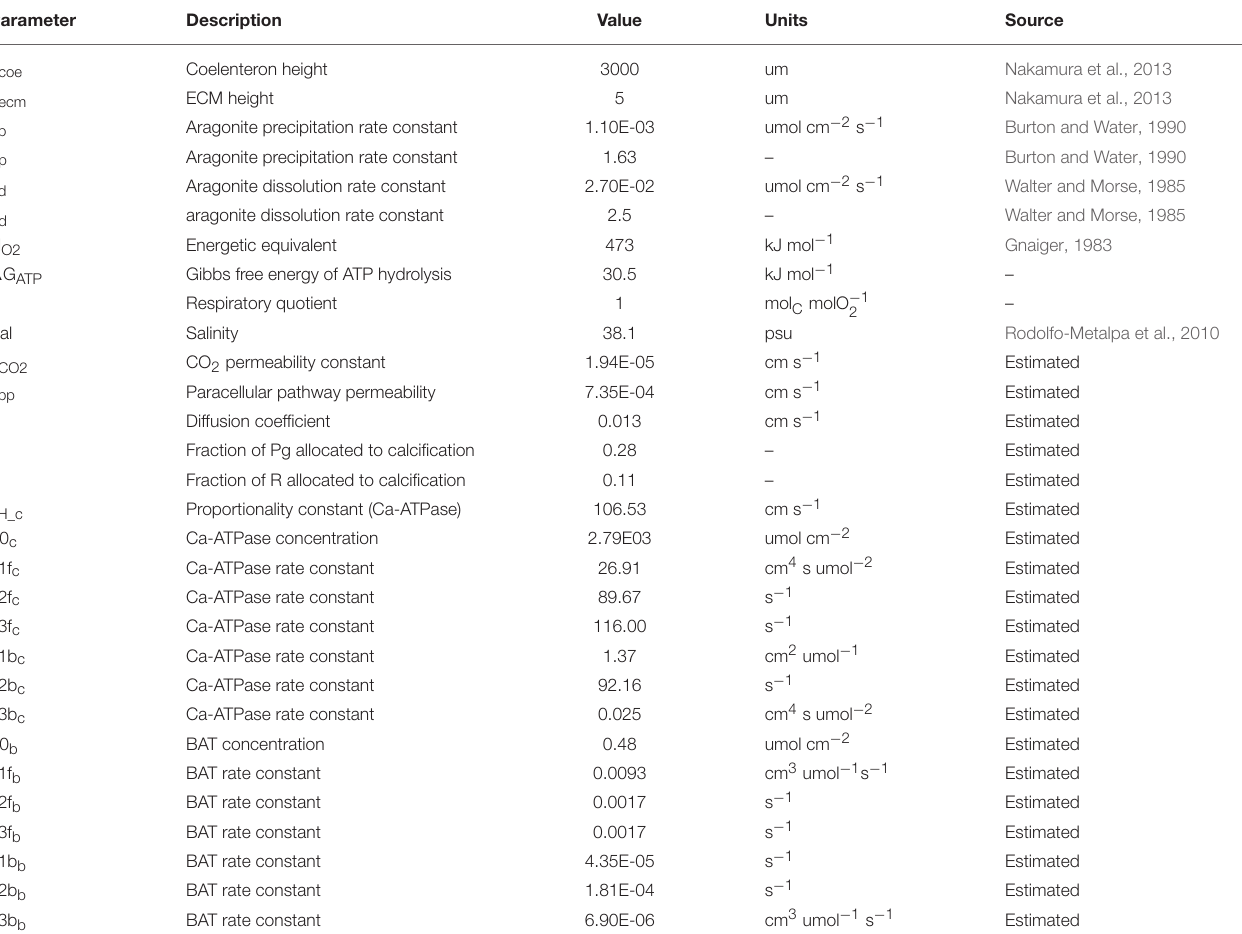
TABLE 2 | All model parameters and